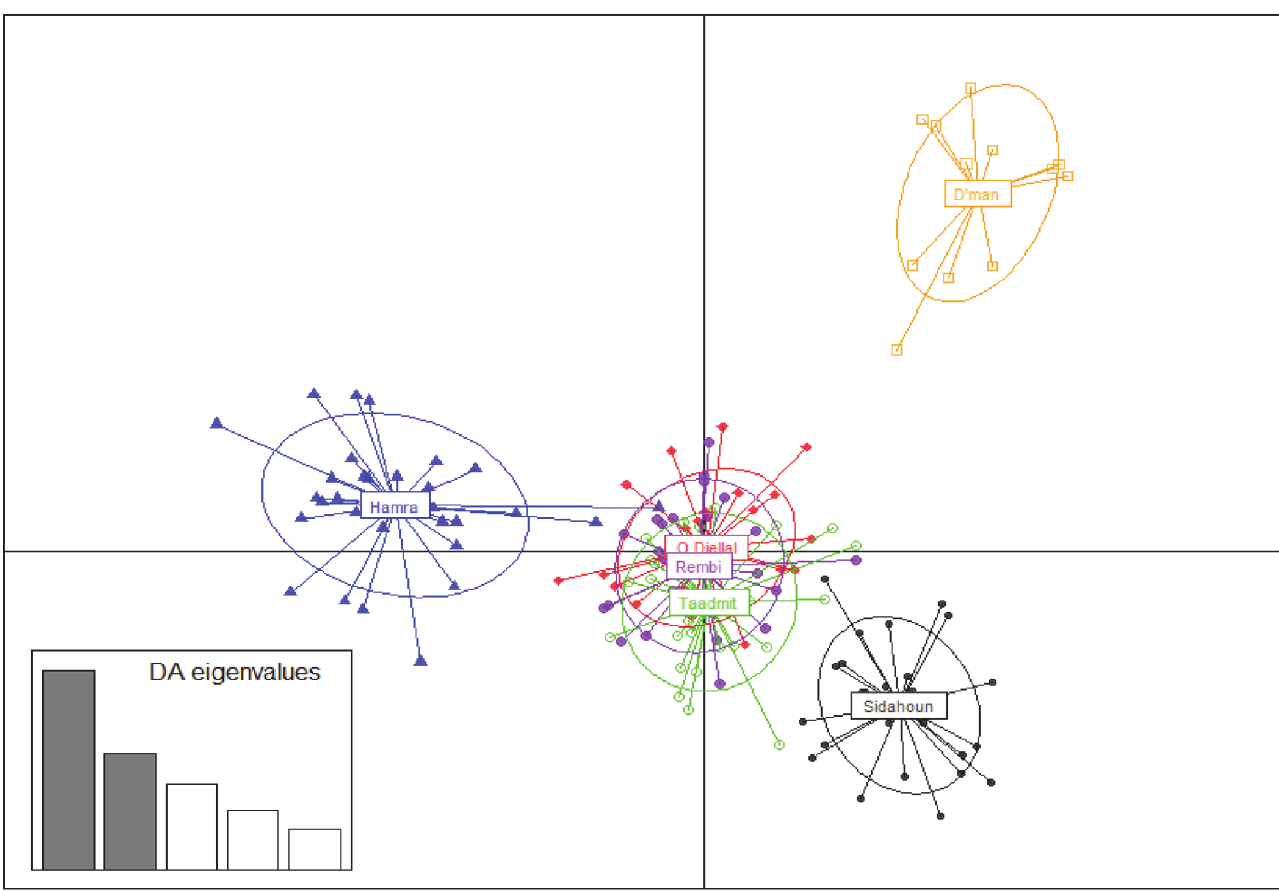
Fig 2. Scatterplot of the first two principal components of DAPC using breeds as prior clusters. Breeds are labeled inside their 95% inertia ellipses and dots represent individuals. The inset indicates the eigenvalues of the first five principal components.